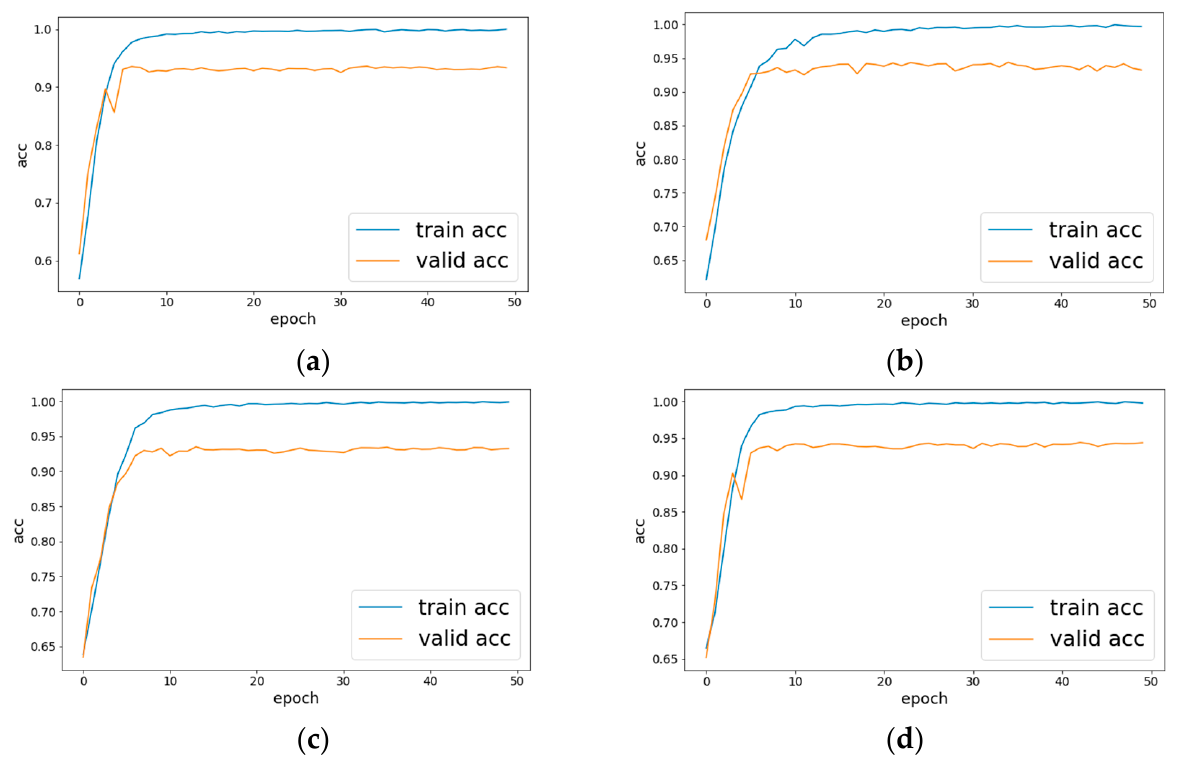
Figure 7. ( a ) Valence classification training results, ( b ) arousal classification training results, ( c ) dominance classification training results, ( d ) liking classification training results improve the training speed.